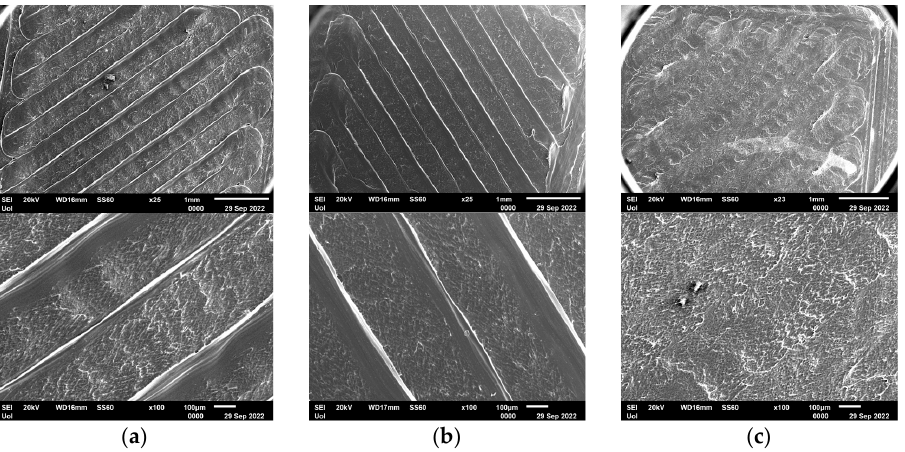
Figure 3. SEM micrographs of modified PLA structures. ( a ) modified PLA, ( b ) modified PLA incubated in 100% DES for 2 h, ( c ) modified PLA incubated in 100% DES for 24 h.